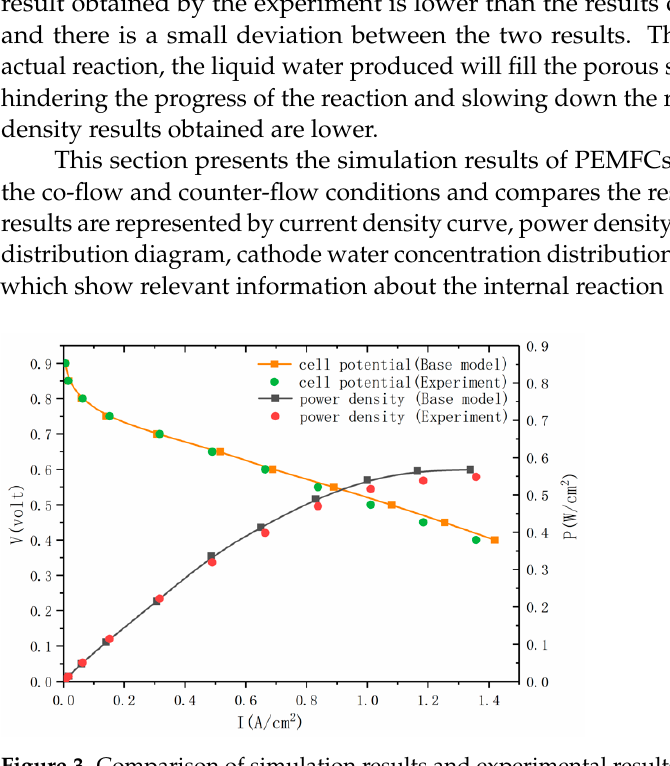
Figure 3. Comparison of simulation results and experimental results.